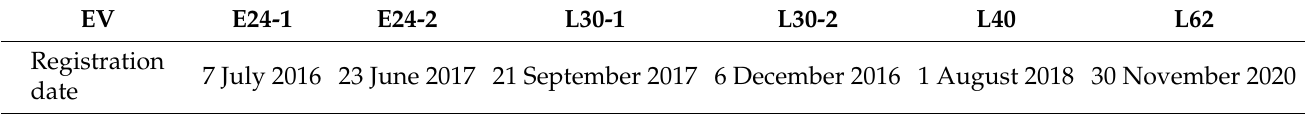
Table 2. Average vehicles usage, distance driven, and FR throughput. * The vehicle provided FR only during the first